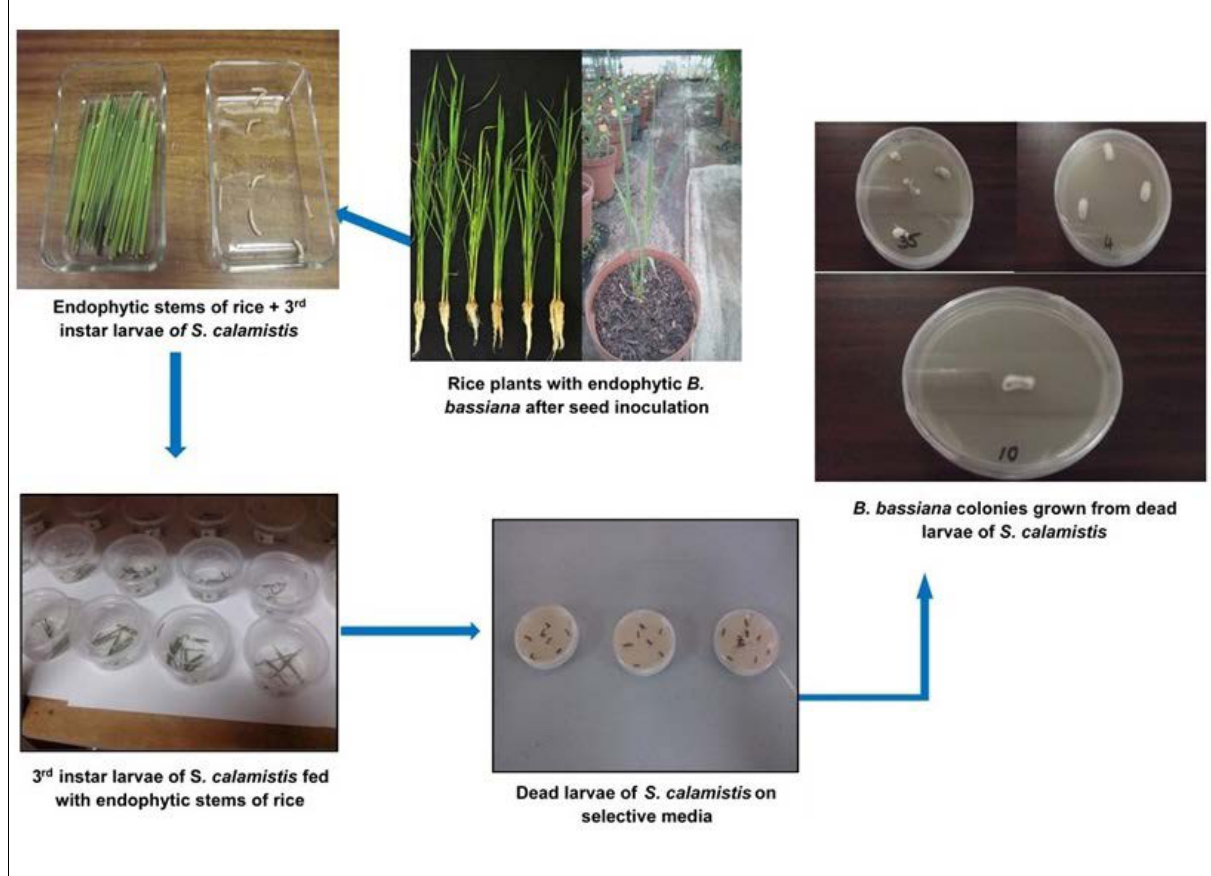
Figure 2: In-vivo screening of endophytic isolates of Beauveria bassiana for pathogenicity activity against third instar larvae of Sesamia